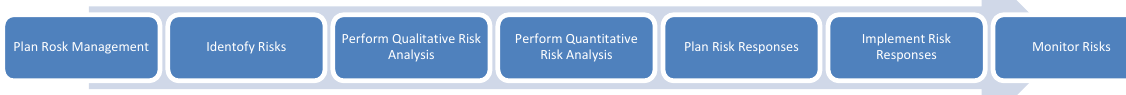
Fig. 1. Clarify the elements of project risk management, Fig. 1. Alt Text : The risk management starts with the risk management plan, then identifying risks,